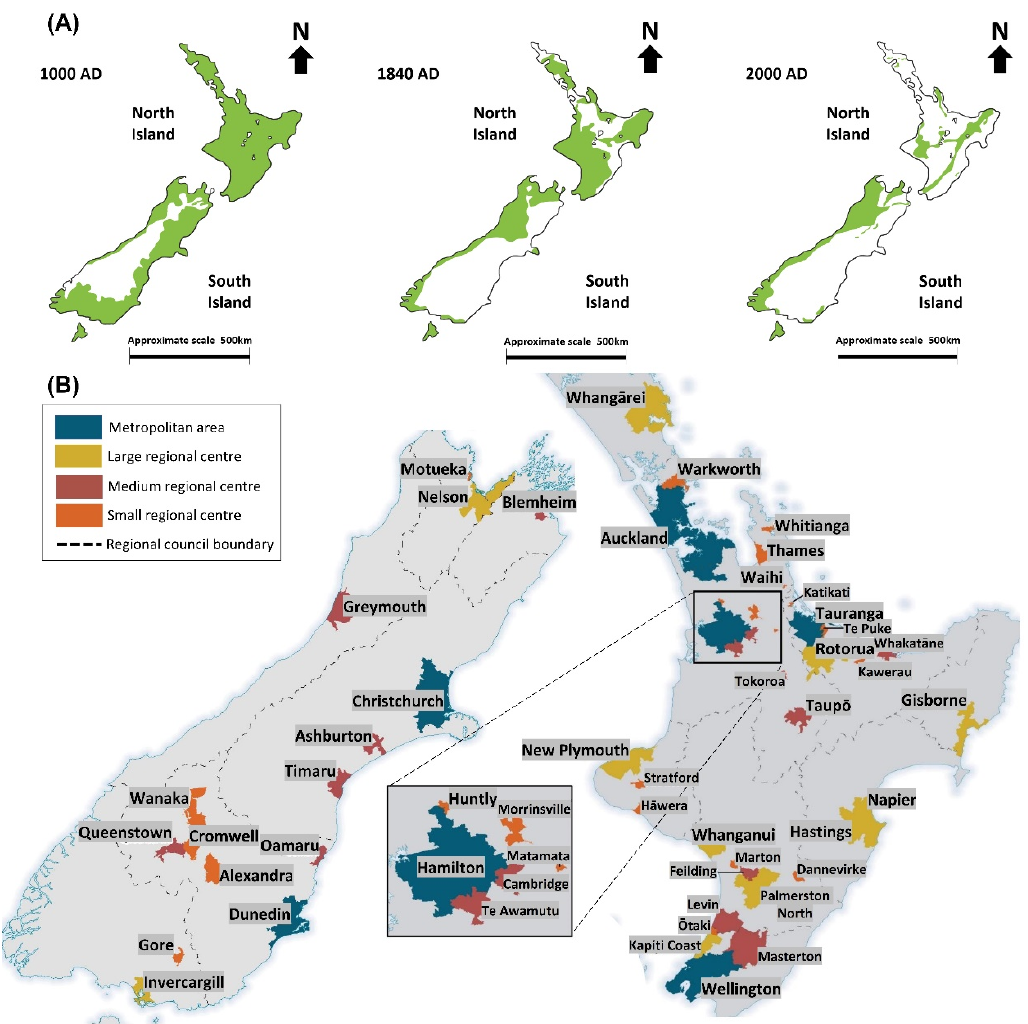
Figure 1. ( A ) Changes in native tree/forest coverage (green color) over time in New Zealand, adapted from Stevens et al. [15] and Nomura et al. [20]; ( B ) functional urban areas by type, New Zealand